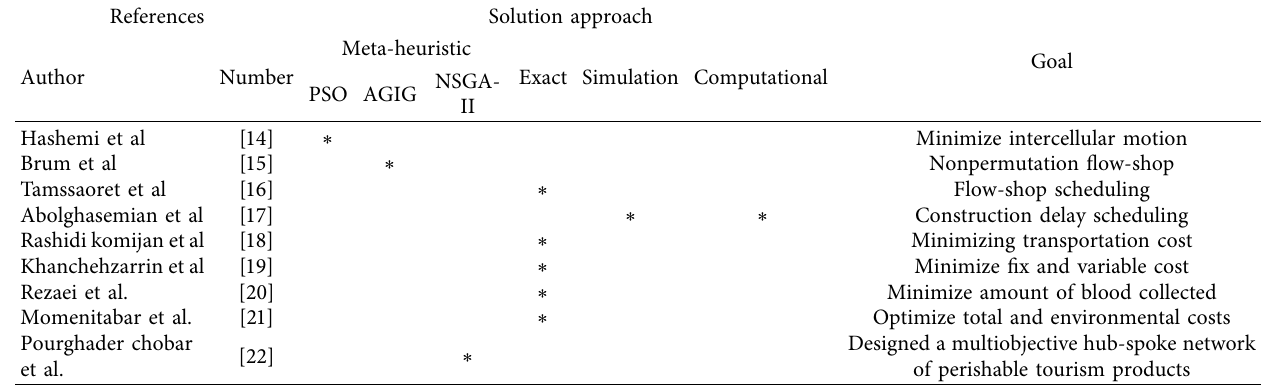
Table 1: Categorized literature